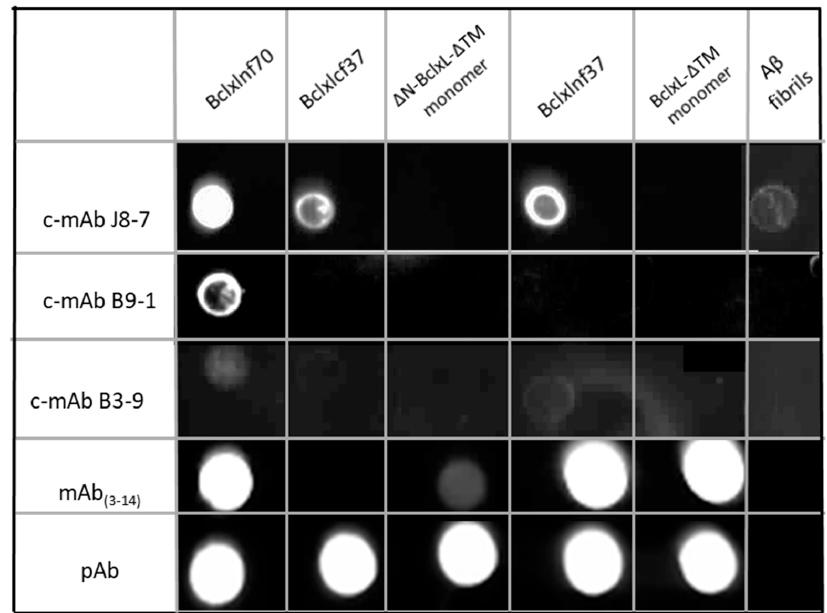
Figure 2. Amyloid specificity determined by dot blots: To test the specificity of c-mAbs J8-7, B9-1, and B3-9 ′ s immuno-recognition, 10 µg of BclxLnf70, BclxLnf37, Δ N-BclxL- Δ TM monomer, BclxLcf37, BclxL- Δ TM and B3-9 (cid:48) s immuno-recognition, 10 µ g of BclxLnf70, BclxLnf37, ∆ N-BclxL- ∆ TM monomer, BclxLcf37, BclxL- ∆ TM monomer, and A β fibers were spotted for dot blot immuno-detection. Controls